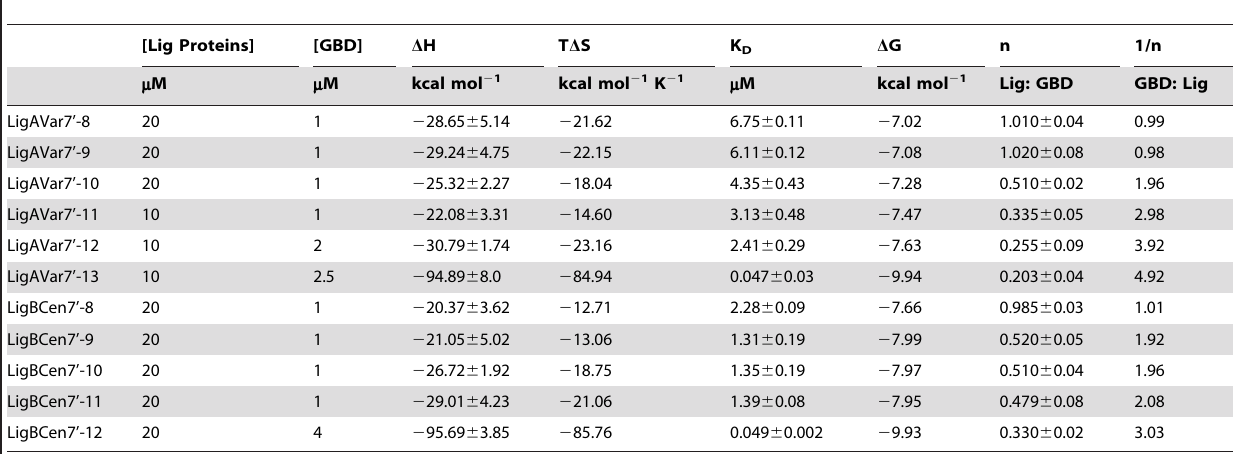
Table 3. Thermodynamic parameters for the interaction of GBD and truncated Lig